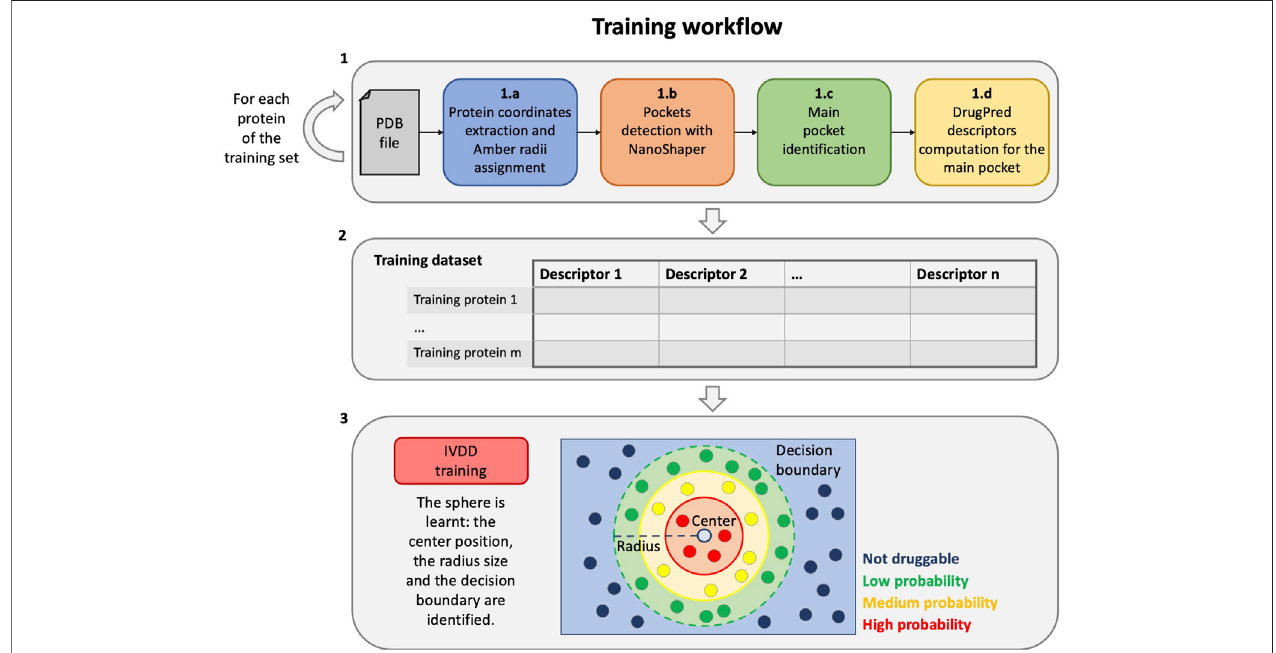
FIGURE 1 | Training work fl ow. From the creation of the training dataset to the training phase of the IVDD